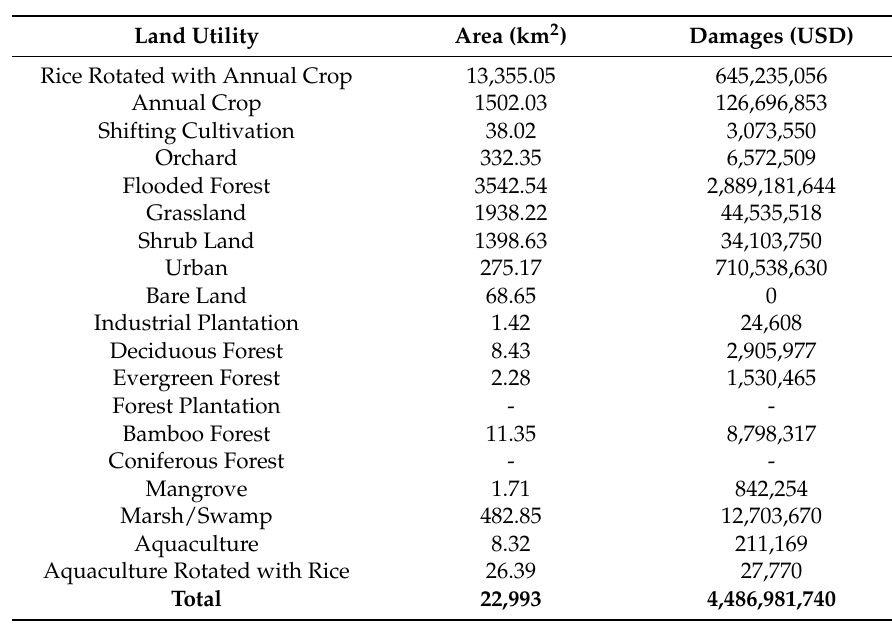
Figure 6. Results of damage assessment for land cover categories. Color gradient represents severity of damages in USD/m 2 . Table 2. Affected area and damage estimates for land utilities considered in this